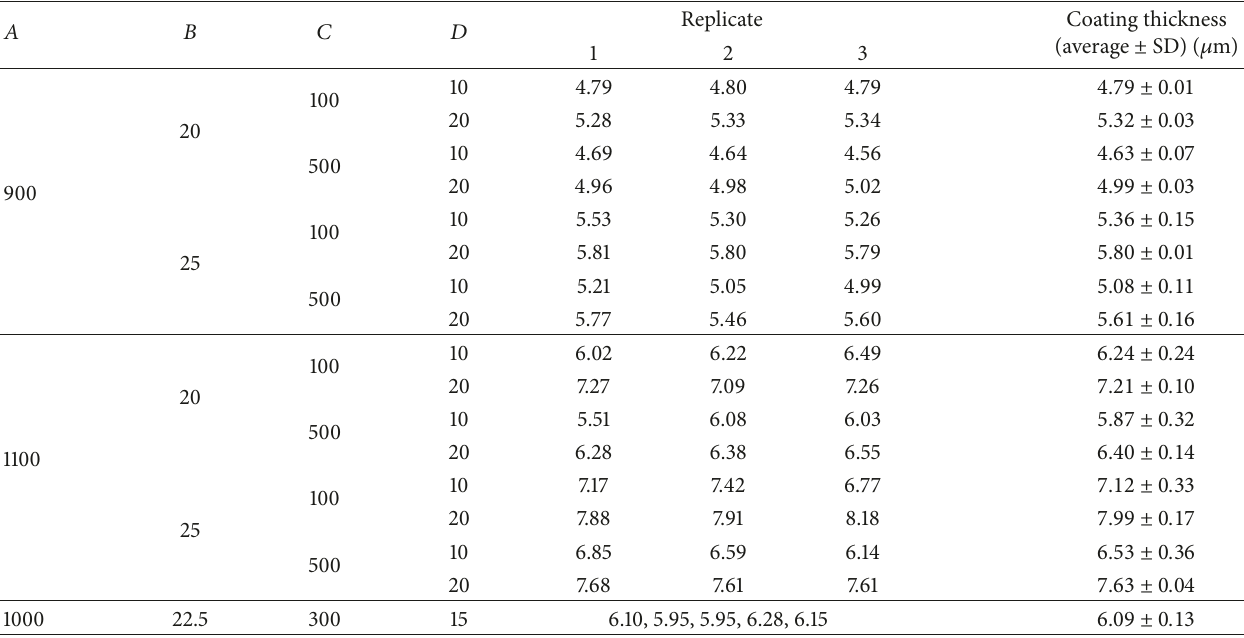
Table 2: Design matrix and corresponding